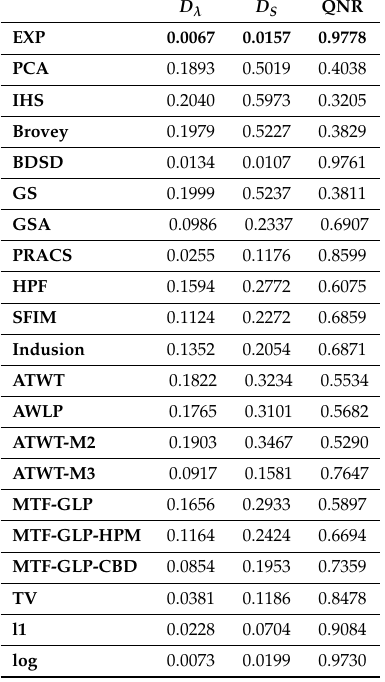
Table 8. QNR quantitative results on the LANDSAT 7-ETM+ Netherland image in Figure 2c. Bold values indicate the best score.